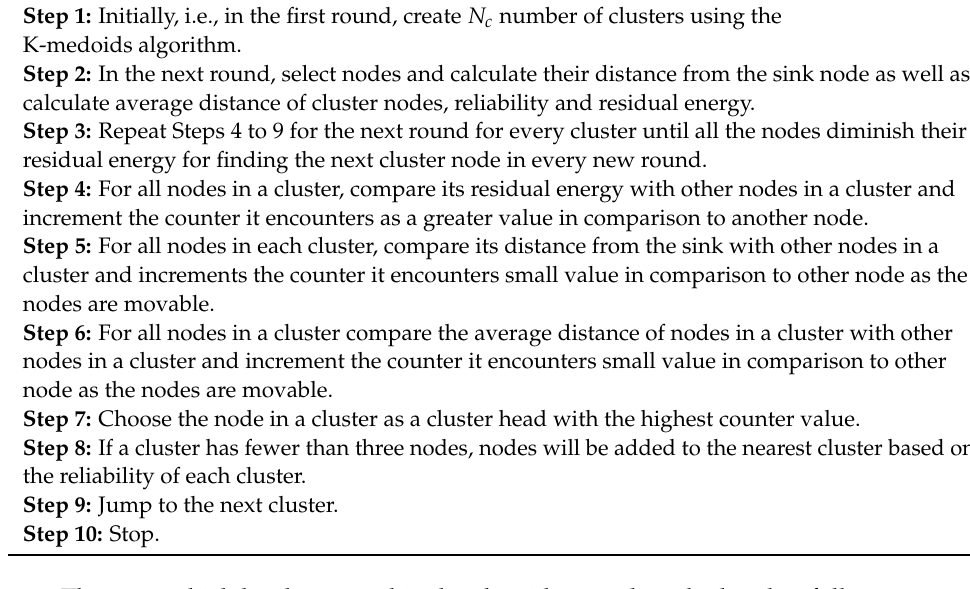
Algorithm 1 CHs Selection Algorithm